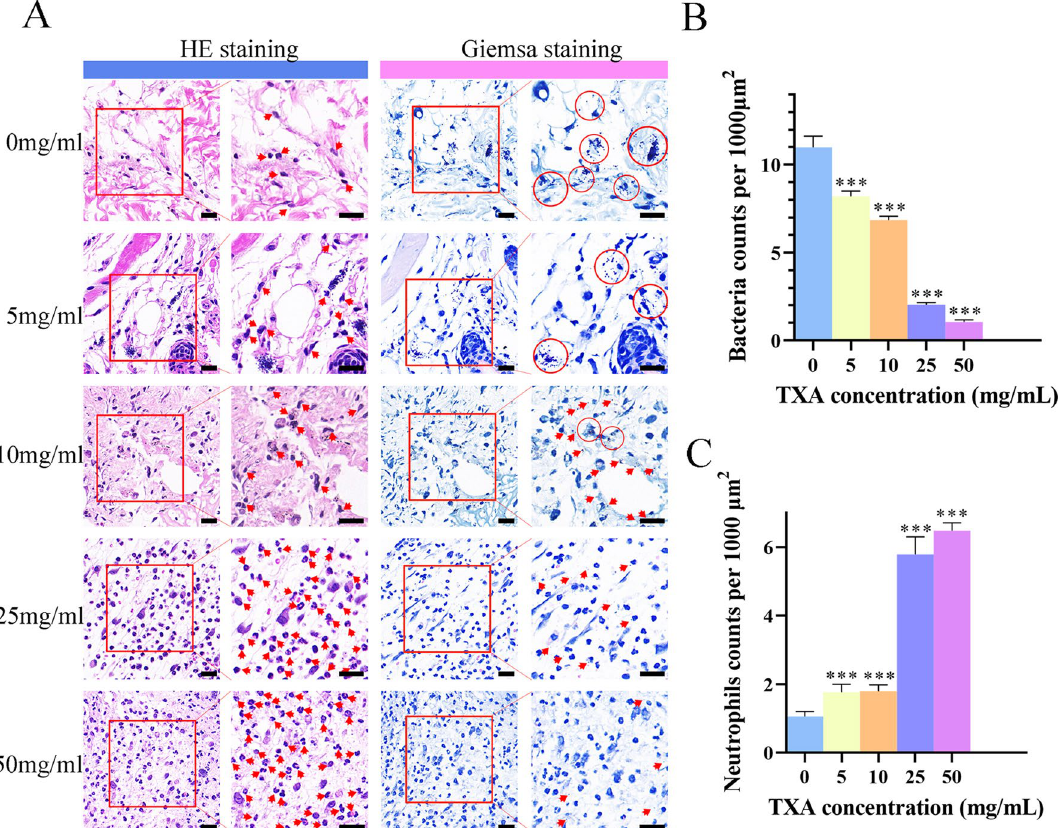
Figure 5. ( A ) HE and Giemsa staining of infection area tissue slices after administration of TXA at different concentrations 24 h after 3 injections. Red arrows represent neutrophils and bacteria in HE staining and Giemsa staining, respectively. Red circles represent the bacteria clumped together. Scale bar: 20 μm. ( B , C ) Quantification of bacteria and neutrophils in the infection area. The results were quantified as the mean of three independent experiments and analysed by one-way ANOVA (* p < 0.05 indicates statistical significance).